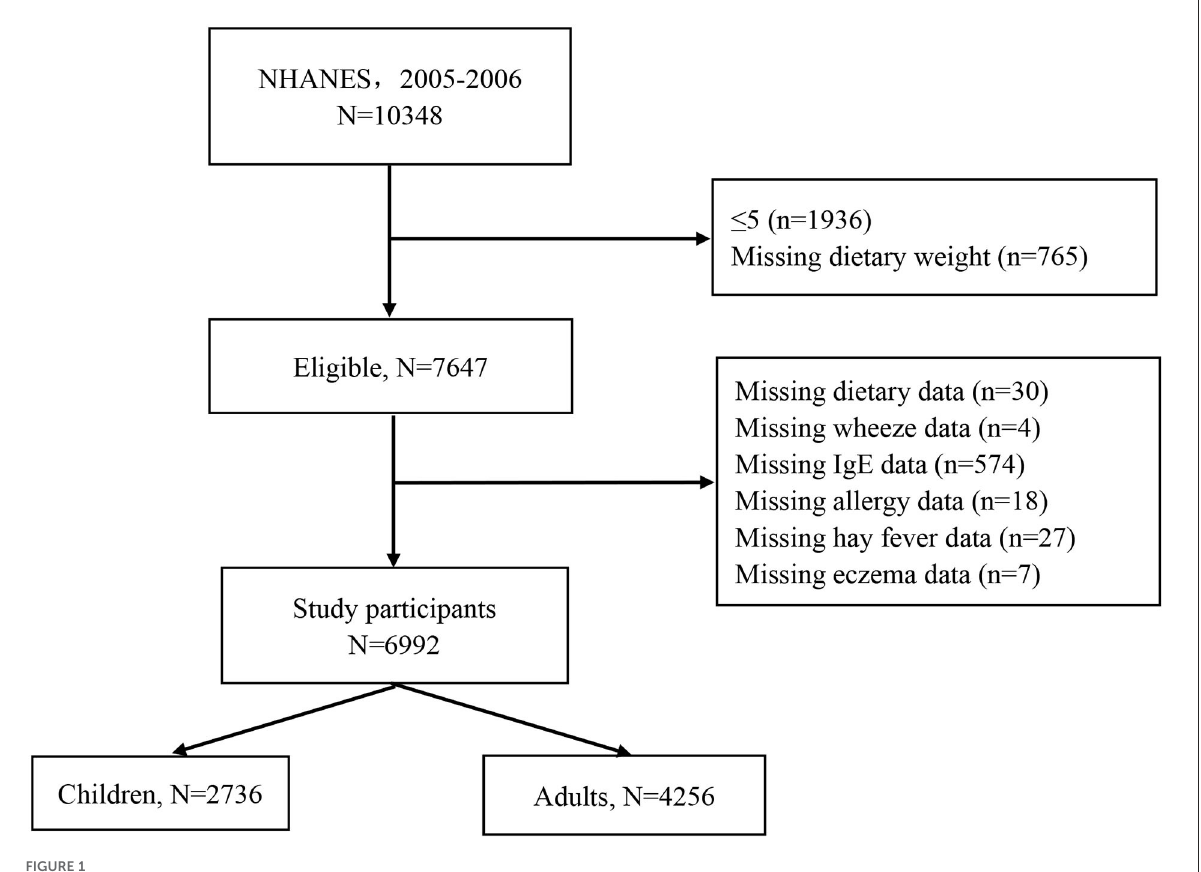
FIGURE1 Participants